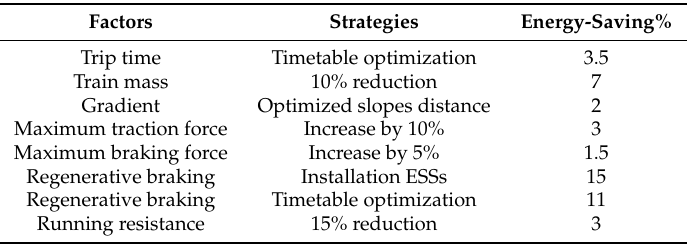
Table 11. Evaluation of different energy-efficient